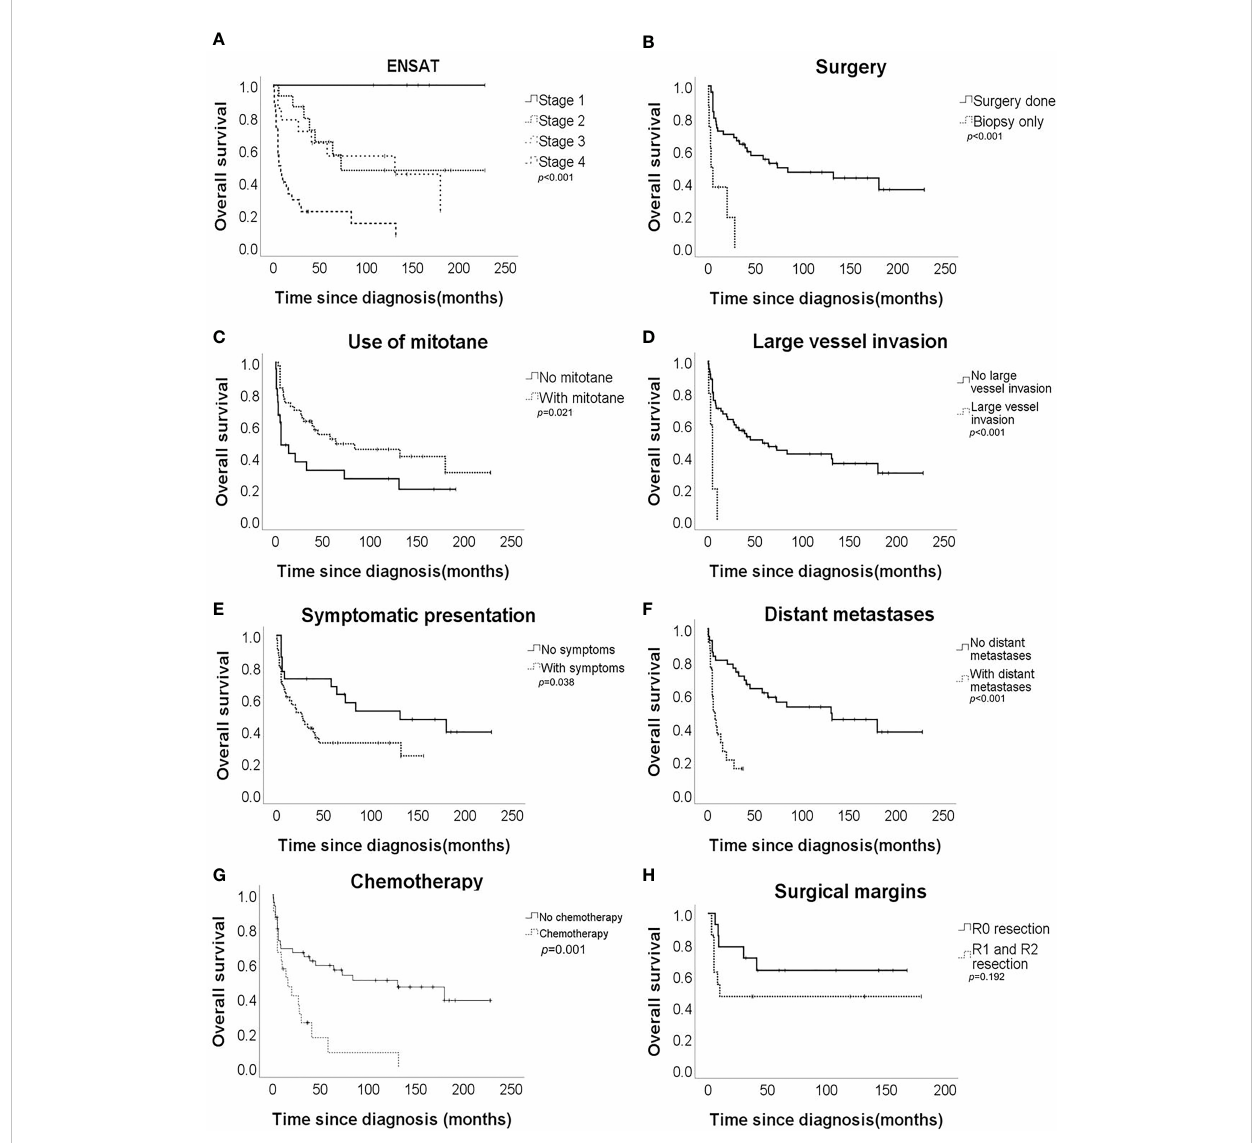
FIGURE 1 Overall survival of the adrenocortical carcinoma patients according to (A) European Network for the Study of Adrenal Tumours (ENSAT) stage, (B) surgical resection, (C) mitotane use, (D) large vessel invasion, (E) symptomatic presentation, (F) distant metastases, (G) chemotherapy, and (H) surgical margin.